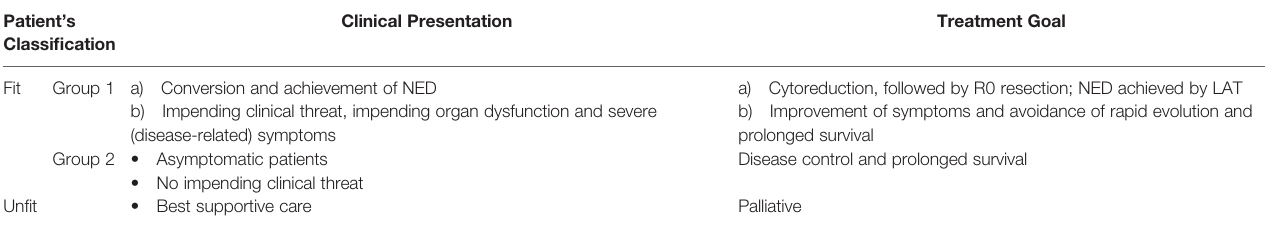
TABLE 4 | De fi nition of cytoreduction and disease control according to ESMO